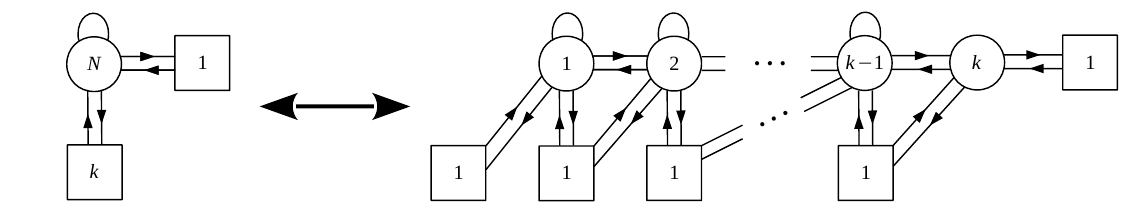
Figure 6 . Rank stabilization uality for generic k